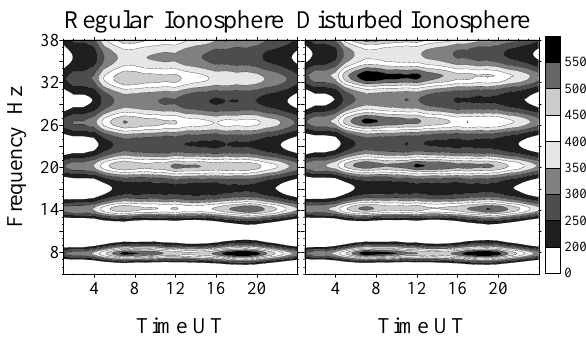
Fig. 8. Dynamic spectra in the regular knee model and the distur- bance of a 1-Mm radius placed over Taiwan. The left panel refers to the quiet cavity, while the right refers to the disturbed cavity.